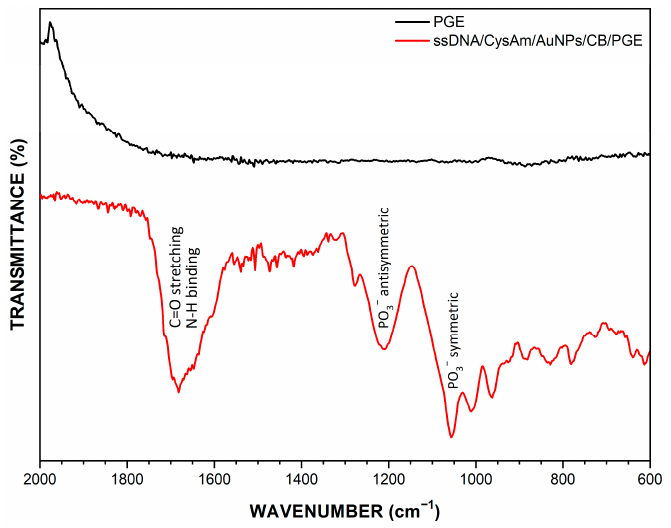
Figure 5. FTIR spectra of immobilized ssDNA capture probe on the CysAm/AuNPs/CB/PGE. The region between 1550 and 1750 cm − 1 has stronger bands that correspond to the N-H bending and double-bond stretching vibrations of DNA bases. Peaks around 1100 and 1245 cm − 1 are attributed to the symmetric and antisymmetric phosphate stretching vibrations of the phosphate backbone of the immobilized ssDNA capture probe. These results are in good agreement with those from the CV and DPV, as well as with the observed vibrational modes from surface-immobilized ssDNA reported in the literature [54].